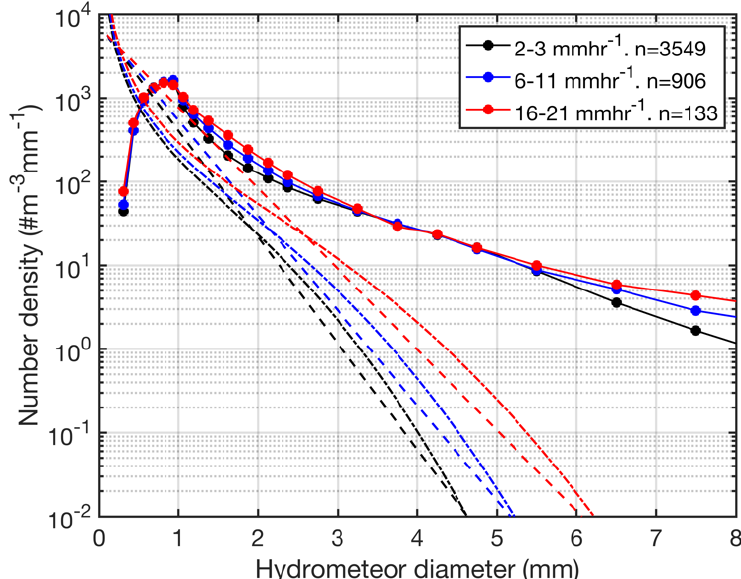
Figure 8. Mean droplet size distributions from the OTT Parsivel 2 disdrometer at the North Sea offshore wind farm conditionally sampled three different RR; 2–3 mmhr − 1 , 6–11 mmhr − 1 and 16–21 mmhr − 1 . The legend shows the number of 1 min periods (n) used to compute these mean DSD for each class of RR. Additionally, shown are the estimates of the DSD derived using Marshall-Palmer (dashed lines) and Best approximations (dashed-dot lines) for the mid-point of each RR range. Note the x-axis has been extended relative to those from the other sites (e.g., Figure 5a) to emphasize the presence of large quantities of high D droplets at this site.